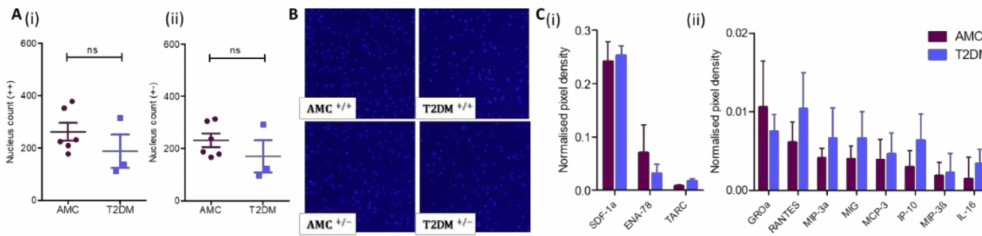
Figure 5. MSC mobility is not impacted by the diabetic status of the marrow donor. ( A ) As assayed through a transwell culture system, the ( i ) chemokinetic and ( ii ) chemotactic migration of MSCs from AMC ( n = 6) and T2DM ( n = 3) cohorts are comparable. ( B ) Representative images demonstrate the underside of a transwell with the migrated nuclei stained with Hoechst. ( C ) Chemokine levels in conditioned media at higher concentrations ( i ) and at lower concentrations ( ii ). Multiple T-test in R demonstrated no significant di ff erence in levels ( n = 4 per cohort). All data are displayed as mean + SEM, ns = not significant, i.e., p >